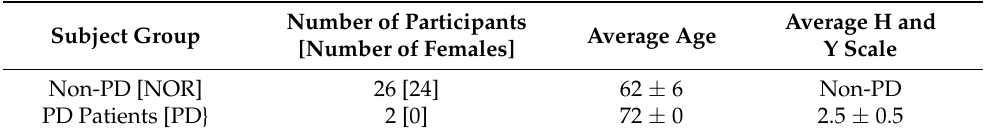
Table 3. Details of study participants for actual GDC